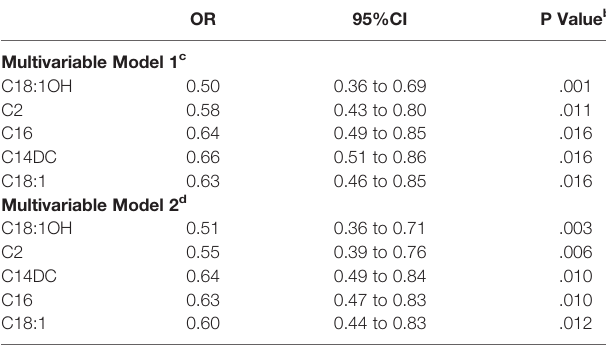
TABLE 3 | OR of acylcarnitine for DR risk in T2DM (univariable model) a . Acylcarnitine